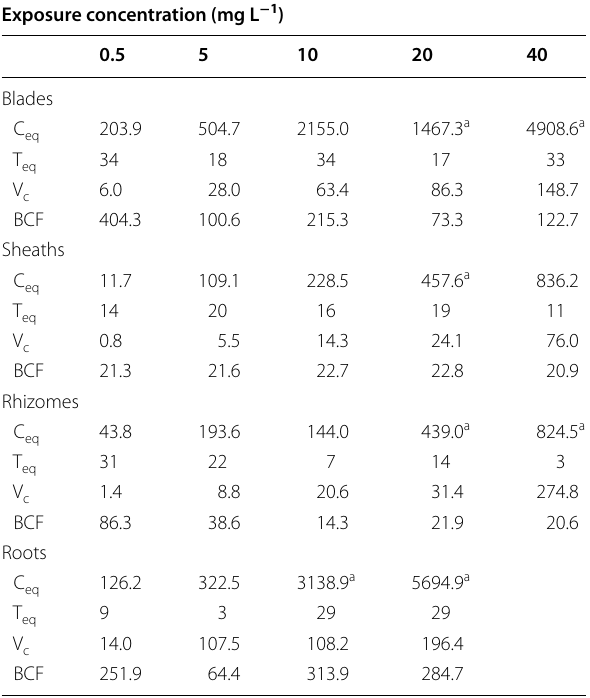
Table 5 Equilibrium concentration, (C wt), time to reach equilibrium (T of uptake (V , in concentration/days) and bioconcentration c factor at equilibrium (BCF)